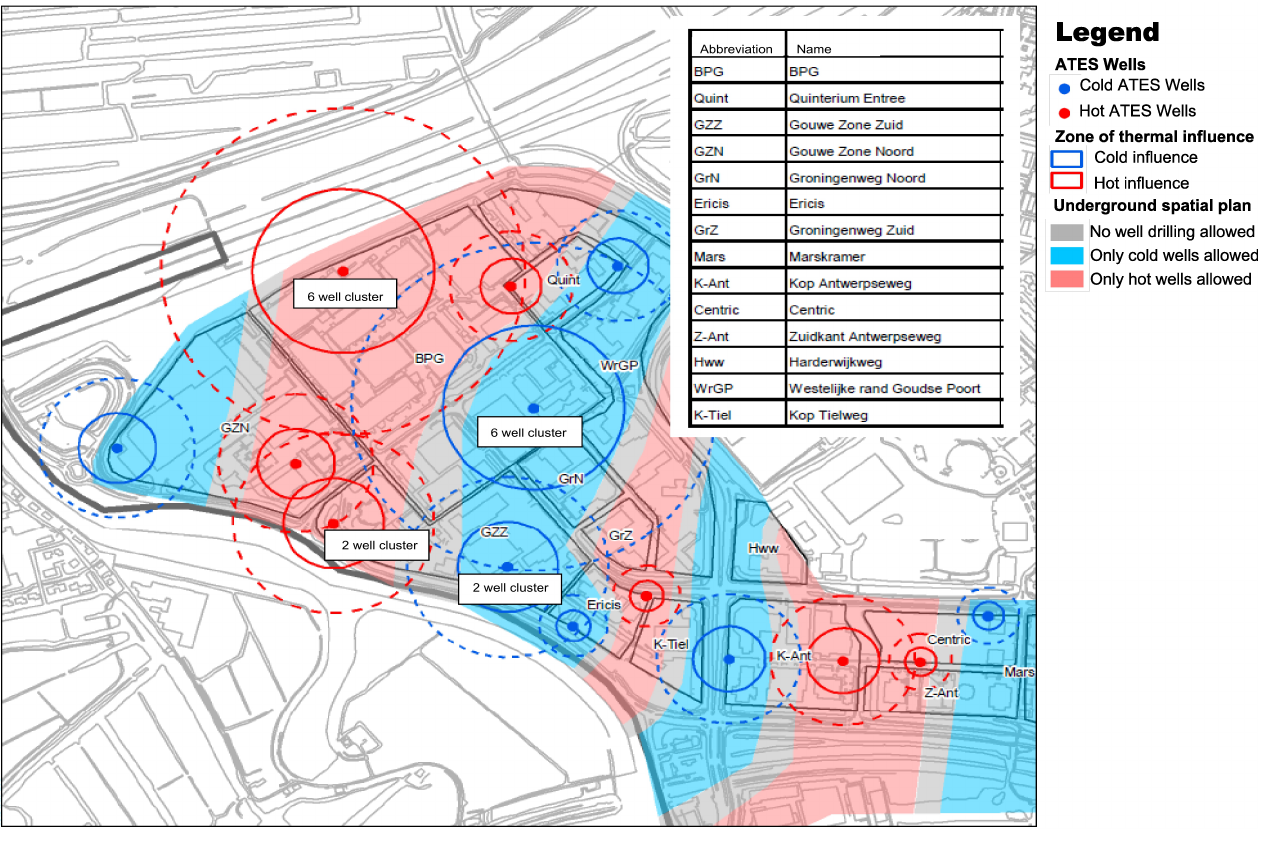
Fig. 4. Subsurface spatial planning map for the second aquifer in the Goudse Poort in Gouda, the Netherlands. Red, blue, and grey regions indicate areas where hot, cold, and no aquifer thermal energy storage wells, respectively, can be installed. Modified from Witteveen+Bos